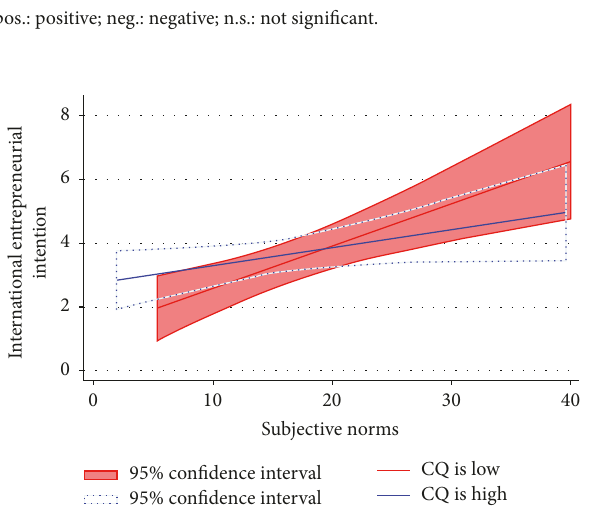
Figure 3: The interaction effect of CQ and SN on